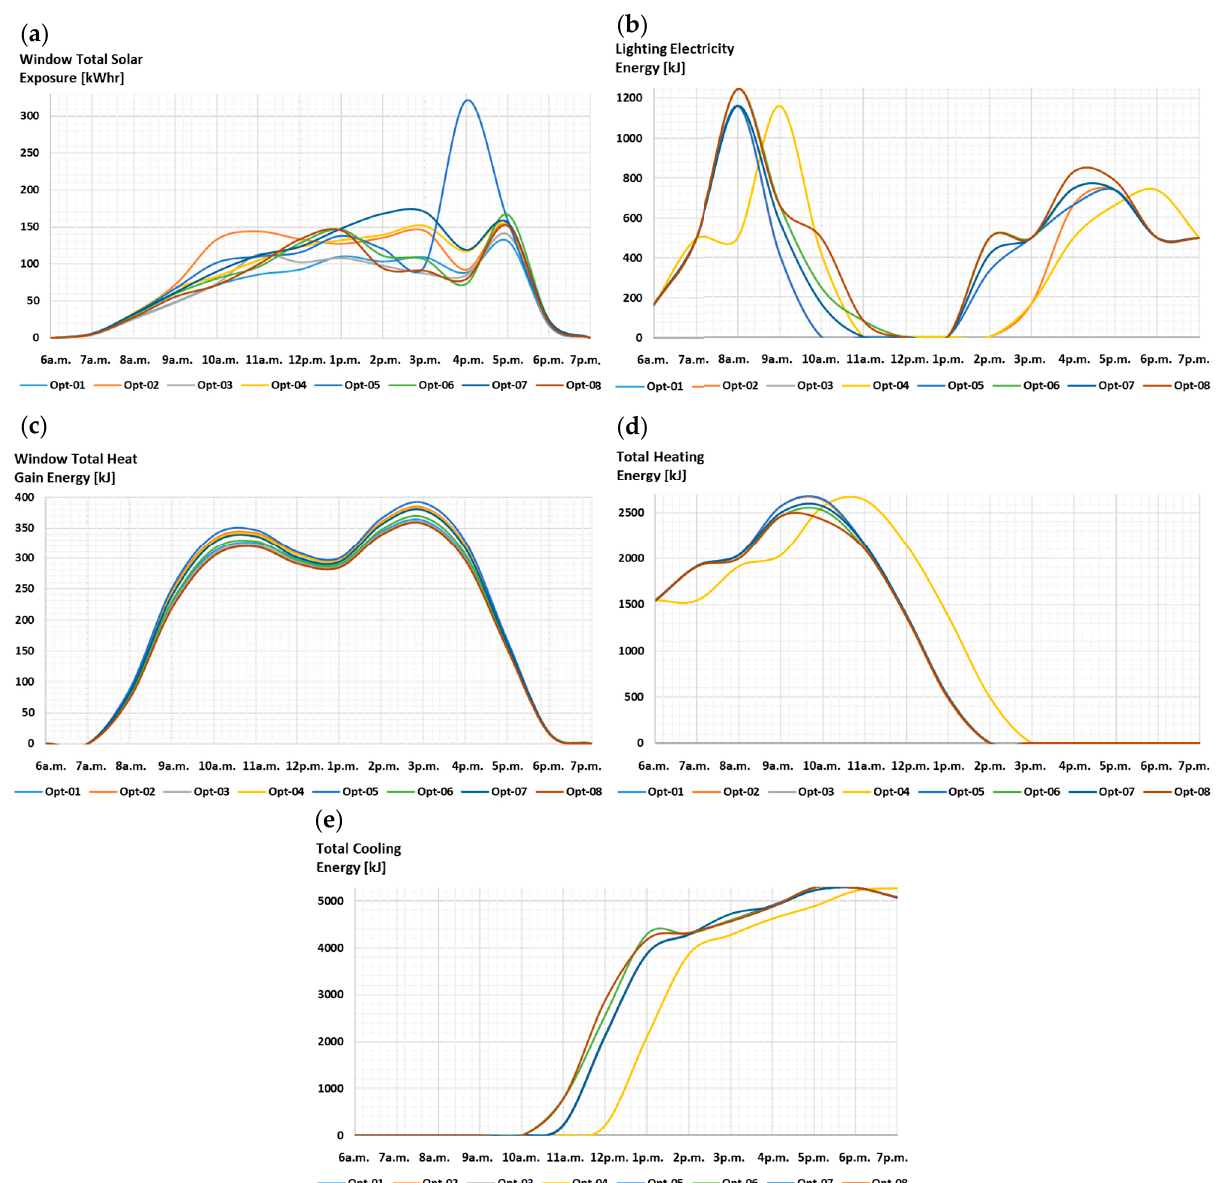
Figure 10. An example of hourly analysis of SLS element properties effect on window solar gain: ( a ) window surface solar exposure; ( b ) artificial lighting electricity for 24 April. The effect of all eight options on the additional lighting was simulated: ( c ) window heat gain energy for 19 March; ( d ) heating energy for 24 April; and ( e ) cooling energy for 17 November. Considering the latent heat flux, the effect of all eight options on the cooling and heating energy was simulated. The effect of all eight options on the window solar gain was simulated.